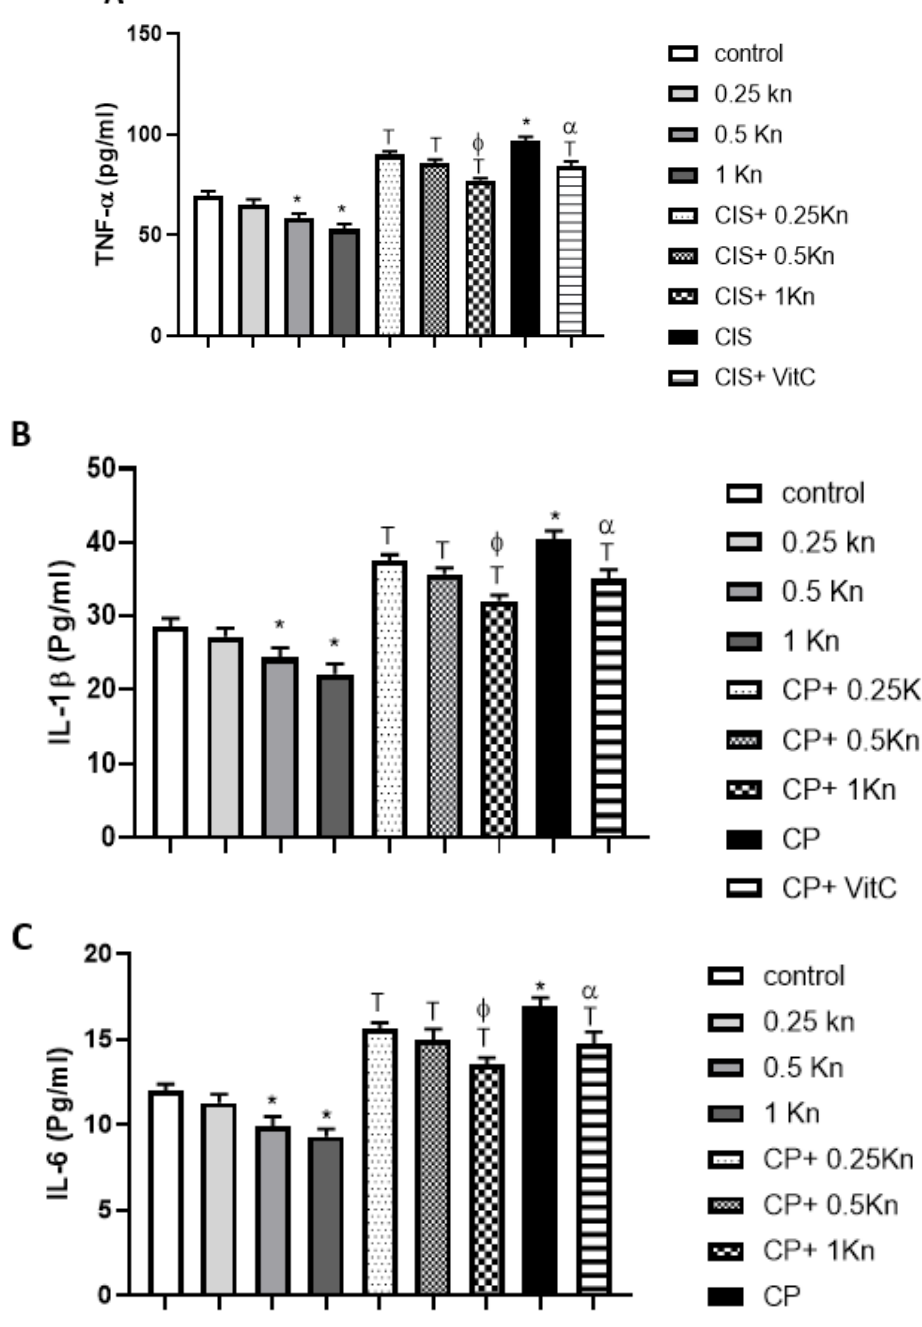
Figure 5. Effect of different doses of kinetin and vitamin C on testicular TNF- α ( A ), IL-1 β ( B ) and LI-6 ( C ) in cisplatin-treated rats. Data are represented as mean ± SEM, *,T, ф and α are significant differences from control, 0.25 Kn, CIS, CIS+ 0.25 Kn and CIS+ 1 Kn groups, respectively, at p < 0.05 where n = 5 – 6. Kn, kinetin;, CIS, cisplatin; VitC, vitamin C .